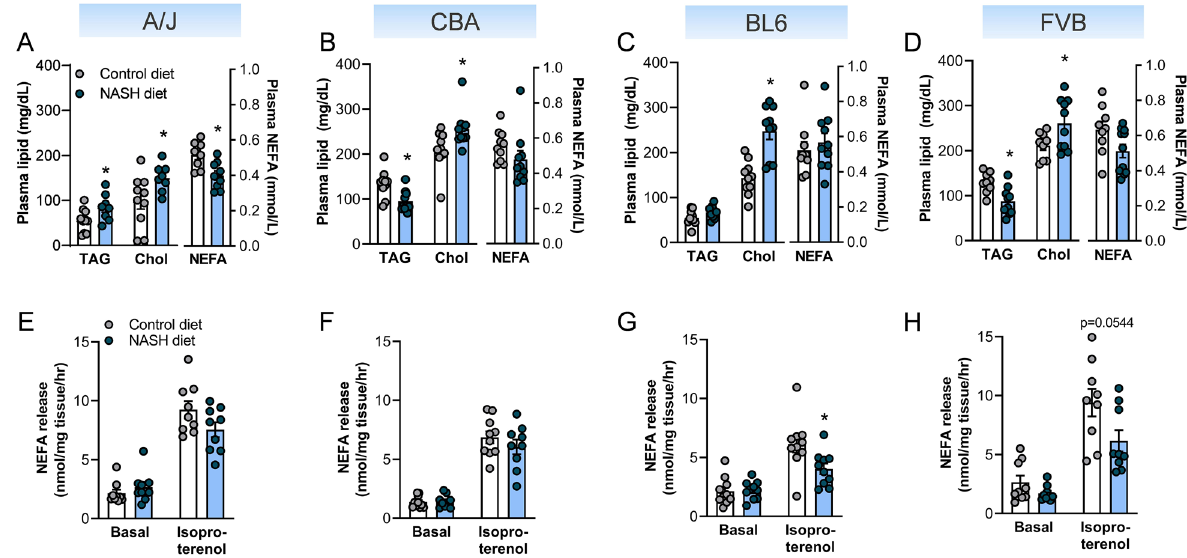
Figure 5. Assessment of plasma lipids and adipose tissue lipolysis in NASH-susceptible mouse strains. Metabolic assessment is shown for the four NASH-susceptible mouse strains, including A/J, C57BL/6J, CBA/ CaH, and FVB/N, with mouse strains sorted by increasing prevalence of NASH and liver fibrosis (from left to right). ( A – D ) Plasma levels of triacylglycerol (TAG) (n = 6–10/group), total cholesterol (Chol) (n = 8–10/group) and non-esterified fatty acid (NEFA) (n = 8–10/group). ( E–H ) Assessment of NEFA release from epididymal adipose tissue explants as a readout of basal and isoproterenol-stimulated lipolysis (n = 8–10/group).